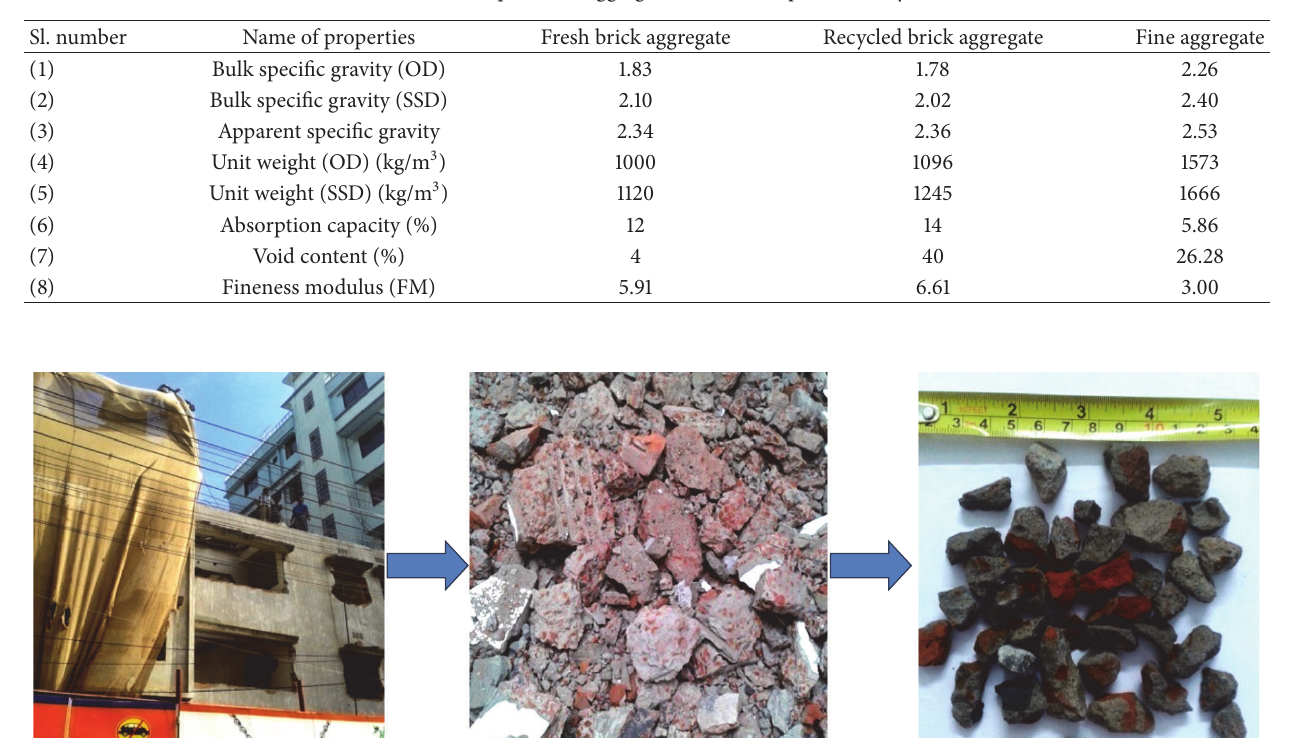
Table 2: Properties of aggregates used in the present study.